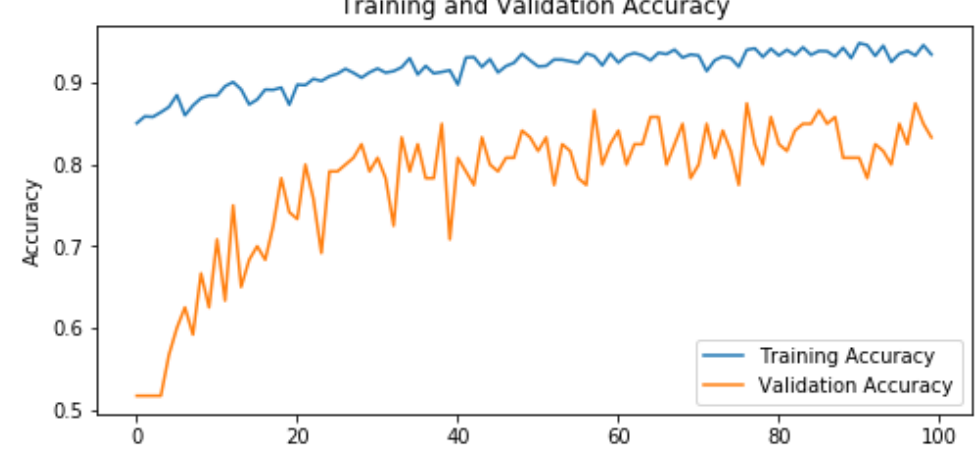
Figure 5. Training and validation accuracy for the proposed model.